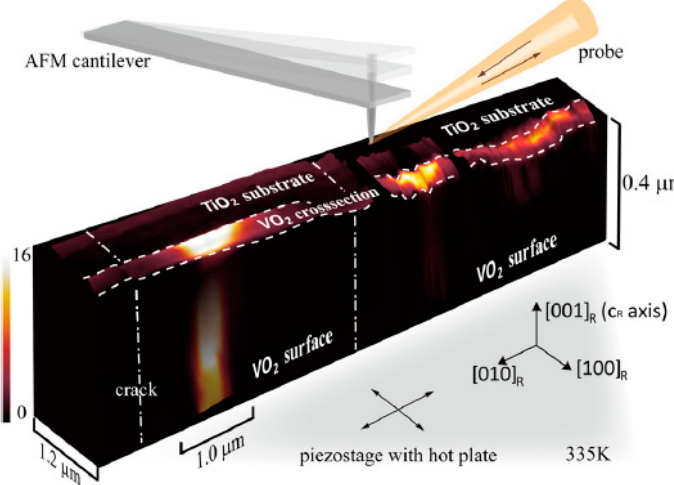
Figure 9. IR s-SNOM image of the cross-section of the VO 2 film at 335 K. The white lines represent the boundary between crystal domains as seen in Figure 8. The cross section shows 3 distinct regions, which indicate the nucleation of metal atoms where a more intense IR s-SNOM signal corresponds to a higher IR conductivity. The image indicates that metal nucleation happens preferentially at the film/substrate interface where the epitaxial strain is strongest. Reproduced with permission from [56], Copyright Applied Physics Letters, 2014.